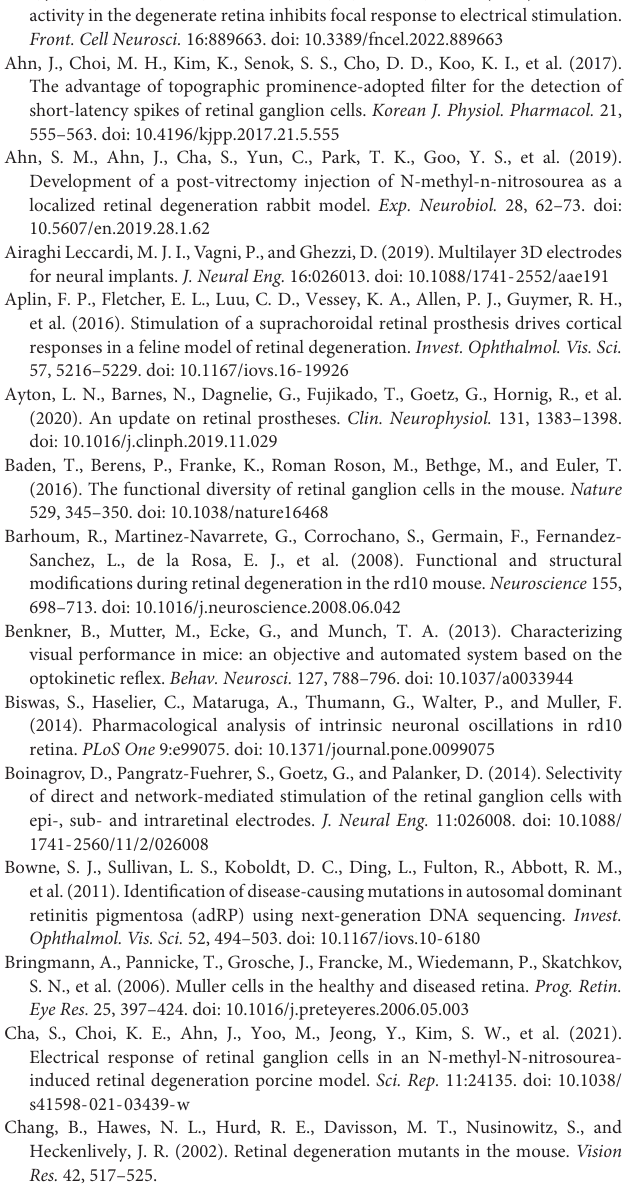
fragments in wild type (+/+), heterozygote ( +/ M), and homozygote mutant (M/M) samples, respectively. (C) The exact sequence of knockin mutation was verified by sequencing after TA cloning of PCR product from F1 heterozygotes mice. The desired knockin of mutation R560C (red arrow) with extra 4 silence mutations (black arrows) are shown. Supplementary Figure 2 | Example of the raster plot and the PSTH of light stimulus-responsive RGCs. The raster plot shows the time stamp of RGC spikes for each trial. The PSTH shows cumulated spike counts per bin for 50 trials of light stimulation (bin size is 20 ms). The bars above the raster plot represent the 4 s light onset and light offset. The ON and OFF RGCs shown include both the brisk transient (BT) and brisk sustained (BS)